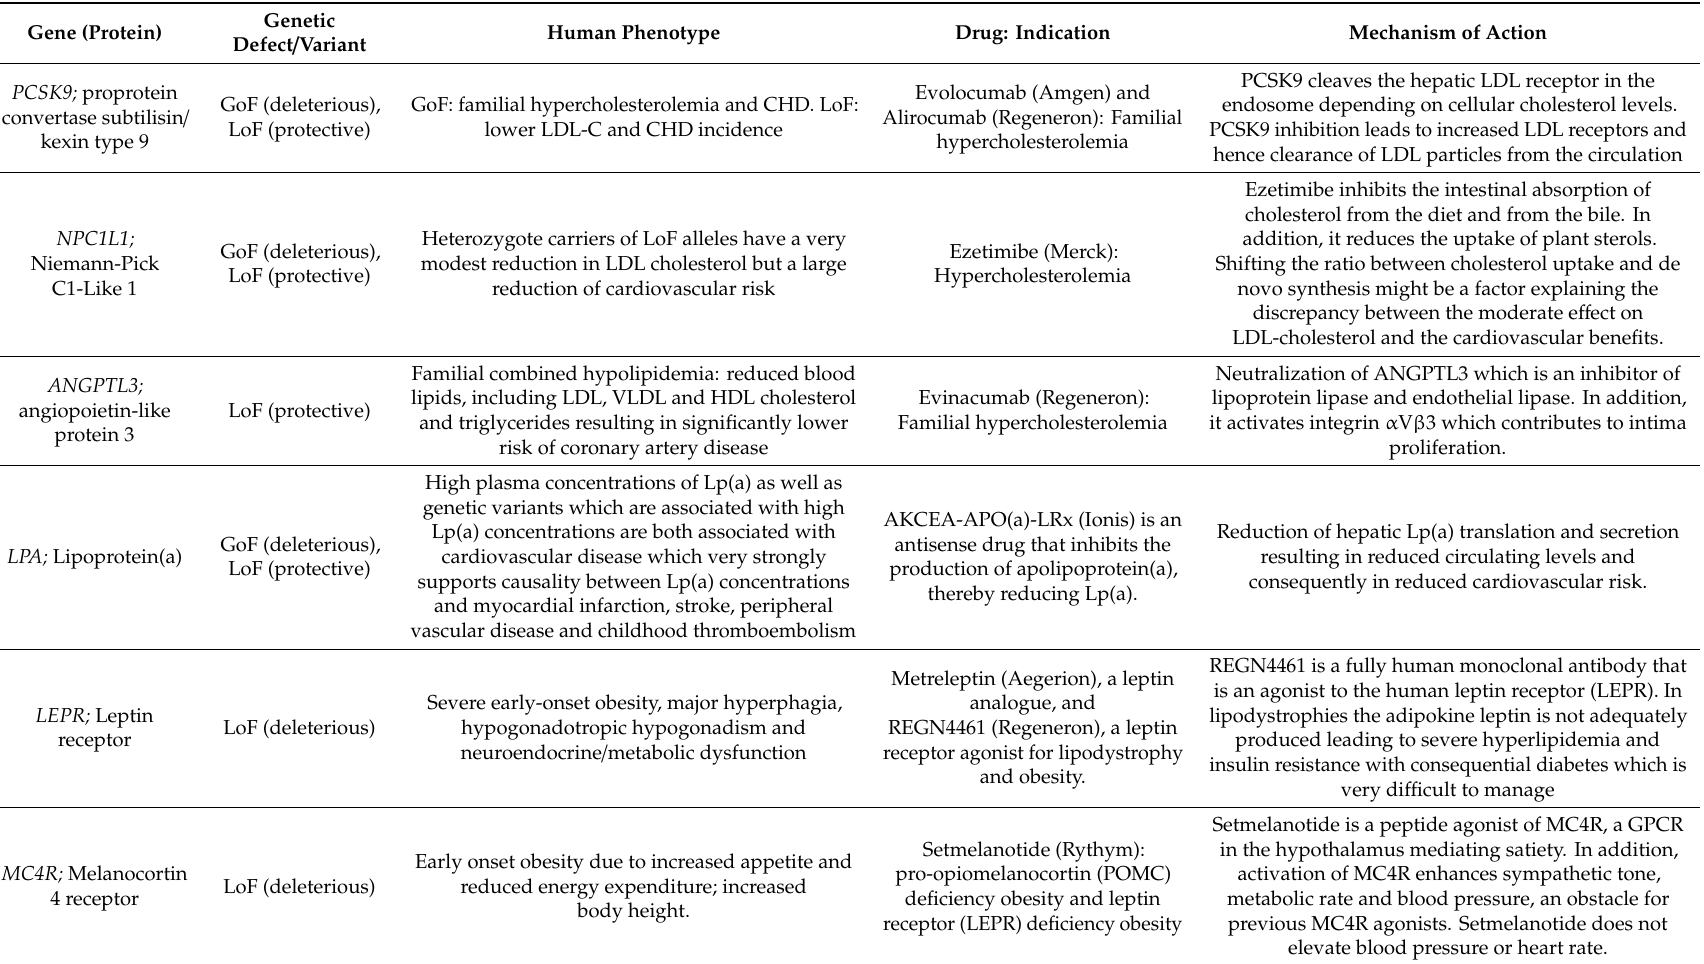
Table 2. Selected examples of genetic conditions supporting the indication of approved drugs. Additional historical gene–drug pairs can be found in Plenge et al. [3]. GoF: gain of function; LoF: loss of function. CHD: coronary heart disease. eQTL: expression quantitative trait